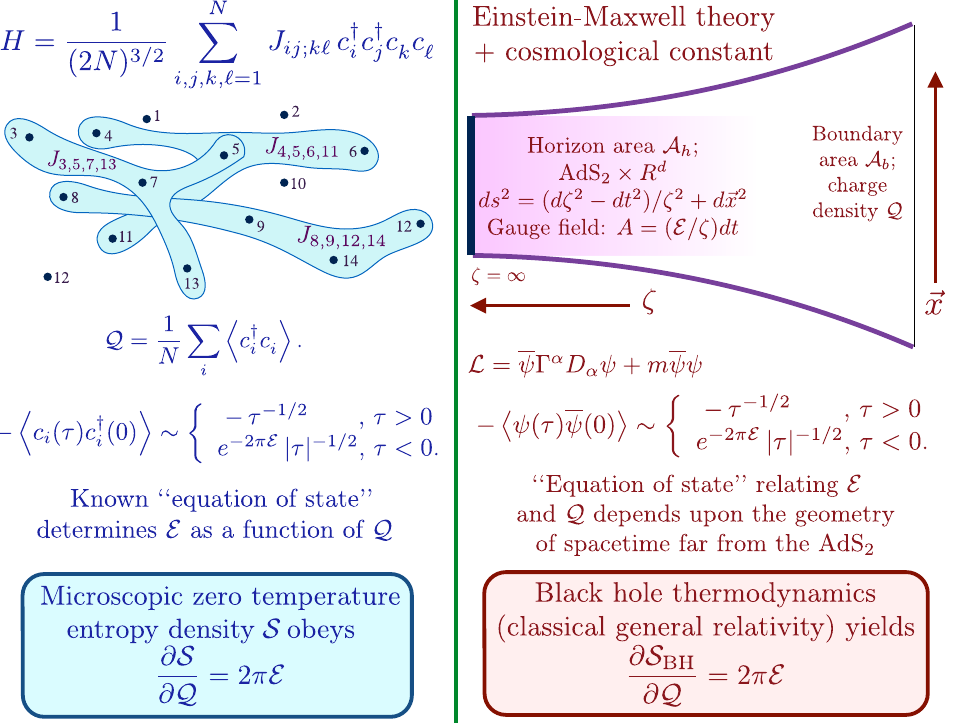
FIG. 2. Summary of the properties of the SY state (Sec. II) and planar charged black holes (Sec. III) at T ¼ 0 . The spatial coordinate ~x has d dimensions. All results also apply to spherical black holes considered in Appendix B. The AdS 2 × R d metric has unimportant prefactors noted in Eq. (55), which are not displayed in the figure. The fermion mass m has to be adjusted to obtain the displayed power law. The spectral asymmetry parameter E appears in the fermion correlators and in the AdS 2 electric field. As the charge Q is increased, the horizon moves closer to the boundary, and its area A density S is related to the area of the horizon via S BH